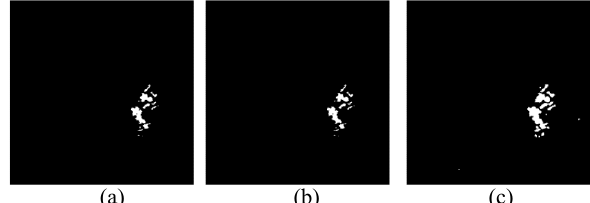
Figure 6. Change images which the backscatter enhanced and Bern. (a) KSW-GA. (b) D-OTSU. (c) RTC.